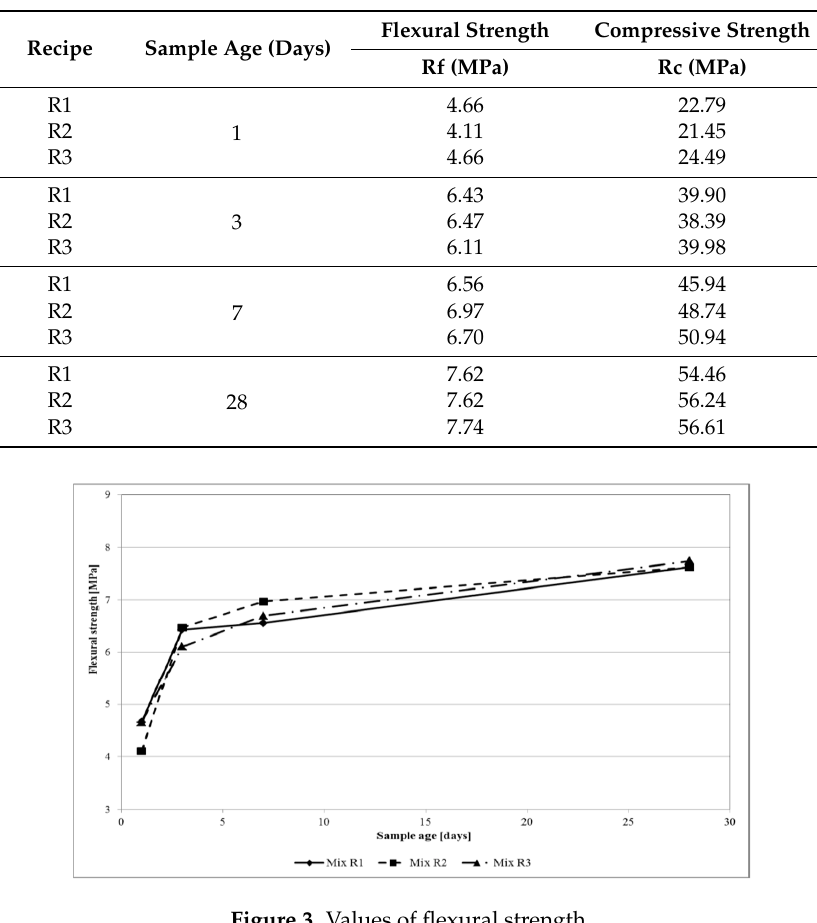
Table 5. Test results of the flexural strength and compressive strength.